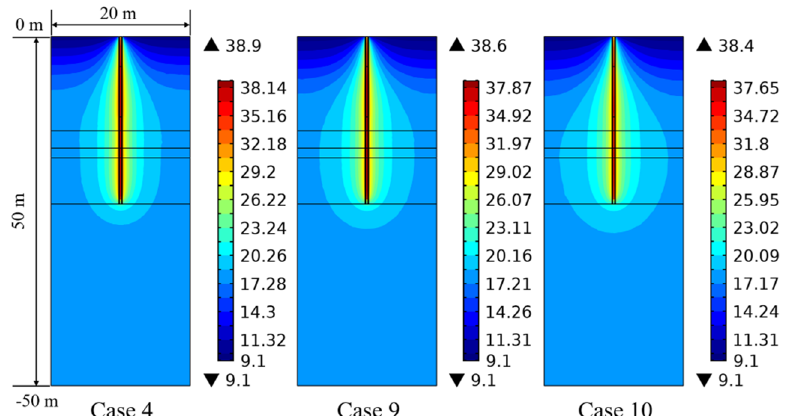
Figure 18. Effect of thermal conductivity of the ground on the ground temperature variation at 90 days (Units °C).